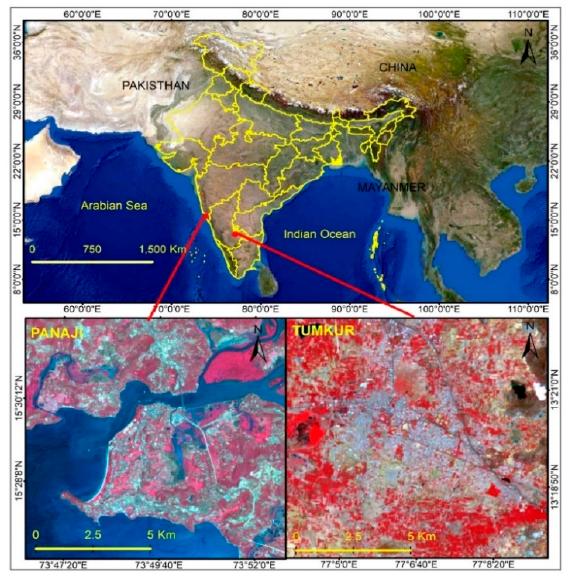
Figure 1. Map showing the city areas of Panaji and Tumkur considered for this study.